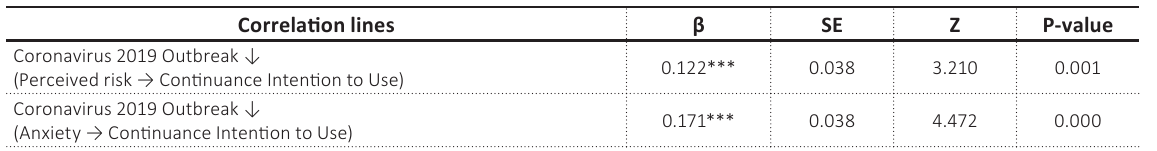
Table 5. Moderating variable